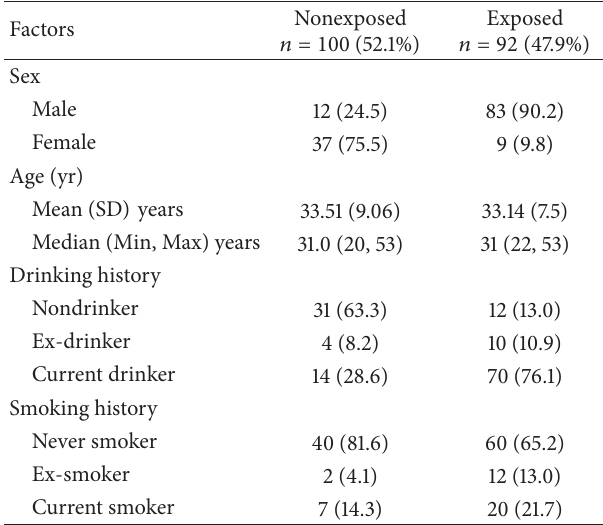
Table 1: Subject